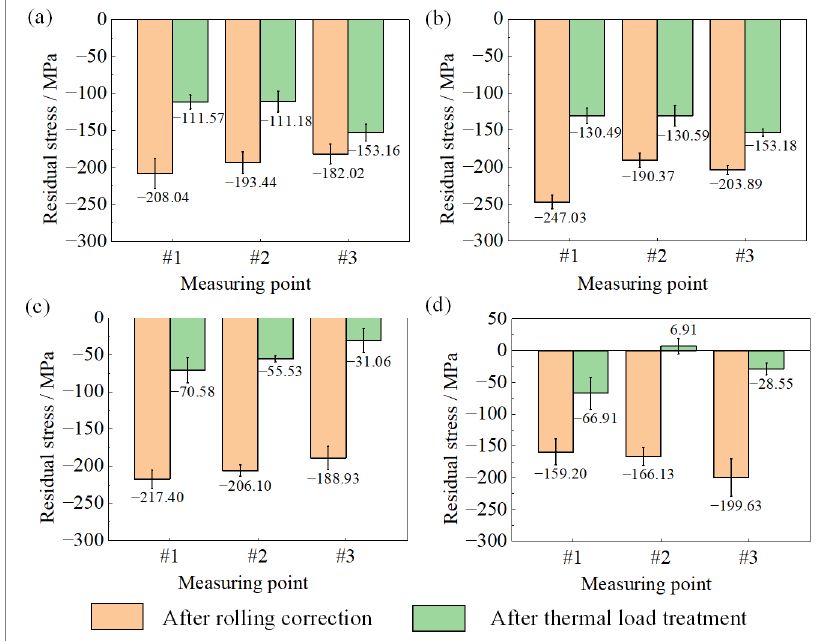
Figure 6. Residual stress test results of the rolling area after rolling correction and thermal load treatment: ( a ) T2/120 °C, ( b ) T3/160 °C, ( c ) T4/230 °C, and ( d ) T5/300 °C.